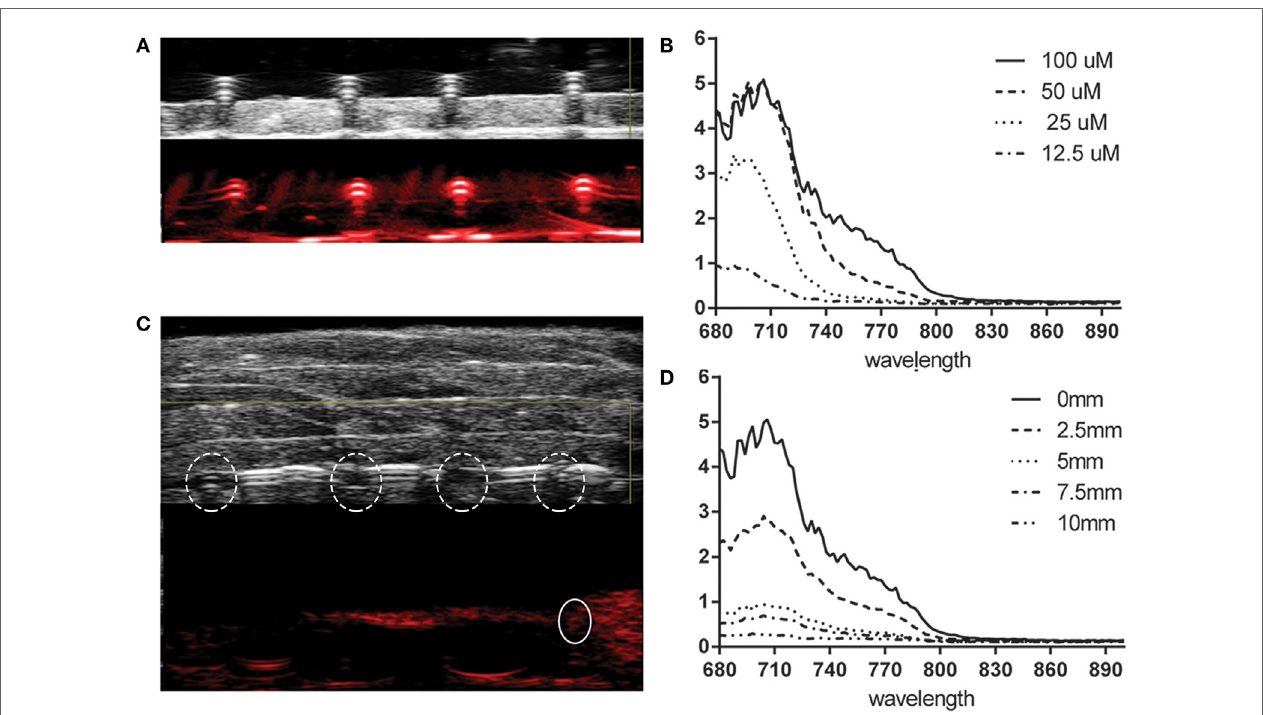
FigUre 2 | Photoacoustic property of hQ4-DTPa . (a) Representative ultrasound (top) and photoacoustic (bottom) images of HQ4-DTPA in a tube phantom at different concentrations (from left to right: 12.5, 25, 50, and 100 μ M). The photoacoustic image was acquired at 700 nm. (B) Corresponding absorption spectra of HQ4-DTPA for the different concentrations. (c) Representative ultrasound (top) and photoacoustic (bottom) images of HQ4-DTPA in the same tube phantom as in (a) , covered with 10-mm-thick meat. The dashed circles indicate the location of tubes, and the solid circle indicates the photoacoustic